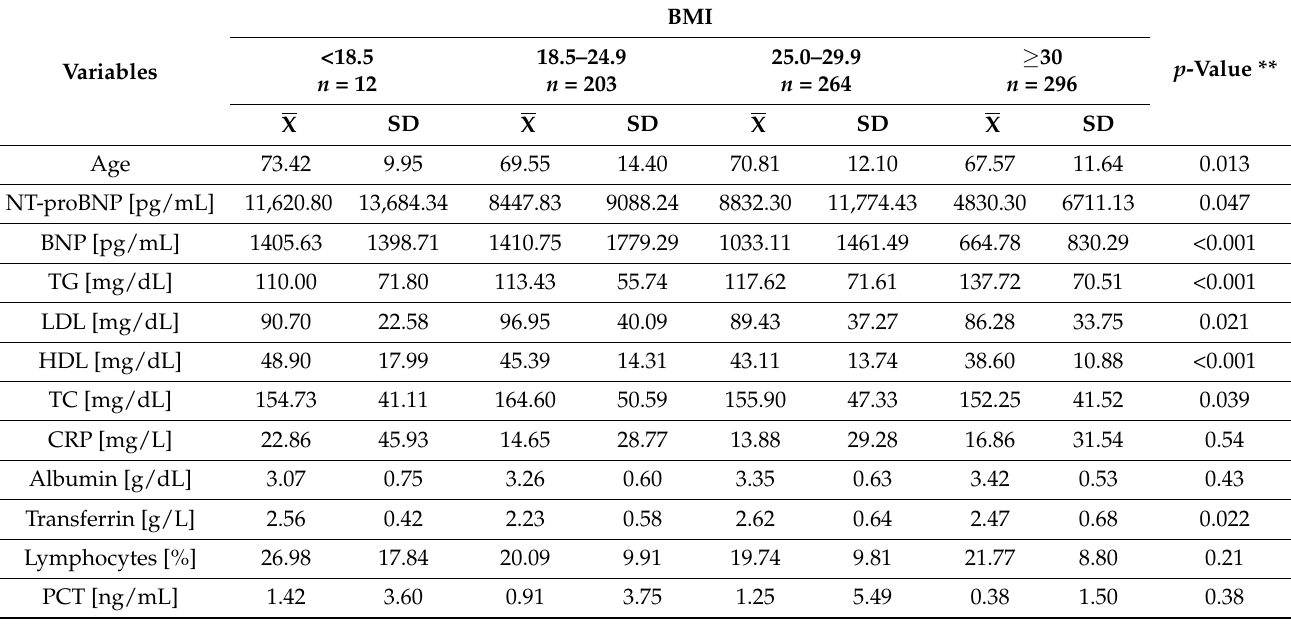
Table 3. The comparison of assessed parameters (quantitative variables) with the ranges of BMI (WHO criteria) values.